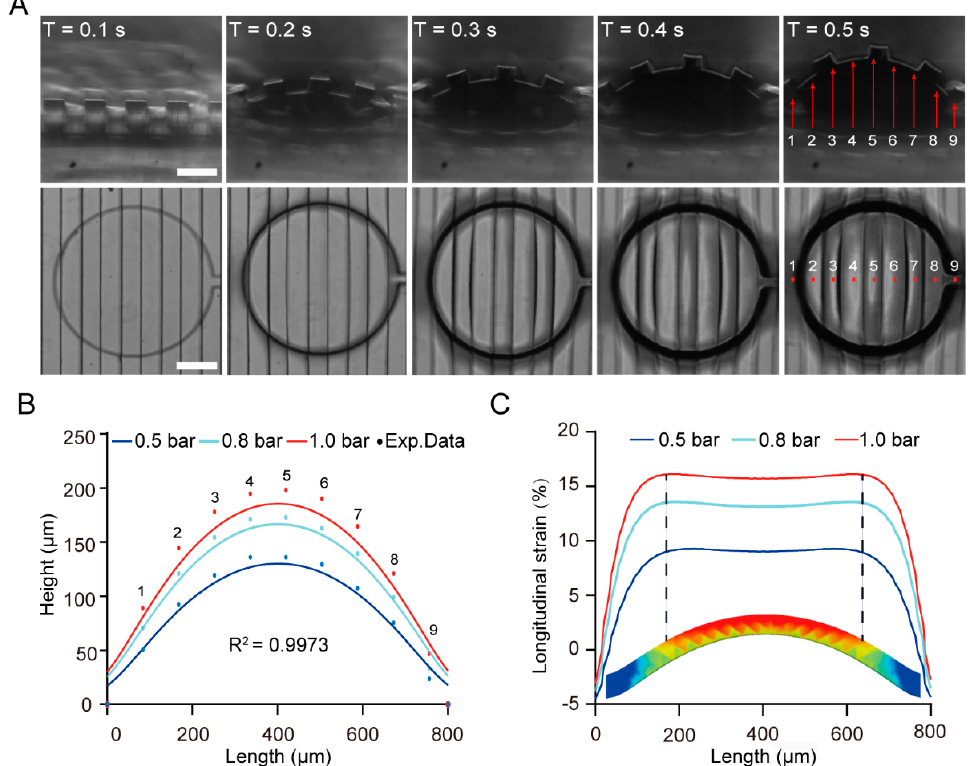
Figure 2. The pneumatically actuated membrane deformation and simulation results of a strain in the ridge structure. ( A ) Pneumatic stretching process of the stretching chip. Images showing the cross ‐ sectional (up panel) and top (down panel) views of one swelling cavity deformation in one inflation cycle under a given pressure ( Δ P = 1 bar) of 1 Hz. Scale bar: 200 μ m. ( B ) Quantitative data showing the maximum height of membrane expansion deformation under the indicated pressure corresponding to the measurement points selected in ( A ). Lines represent the simulation results, and dots show the experimental measurements. ( C ) Plot of the longitudinal strain distribution on a stretched ridge under the indicated pressure conditions. The diameter of the pressure cavity is 800 μ m. The width of ridge is 100 μ m.